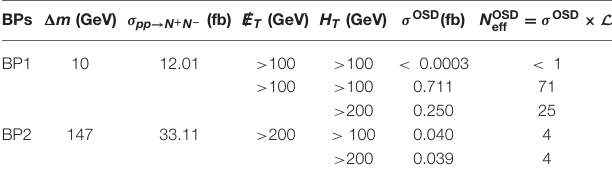
100 fb − 1 after / E T , H T and m ℓℓ =